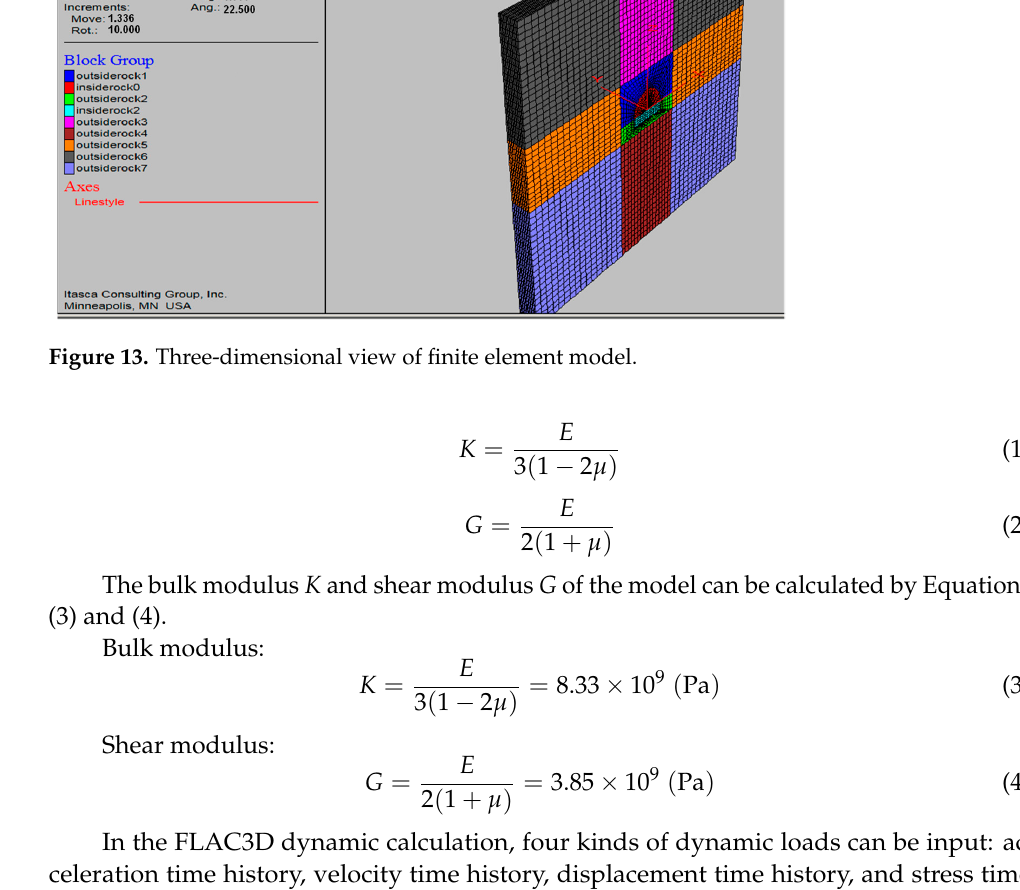
Figure 15. Data after electronic detonator vibration test and transition. The loose circles of the tunnel blasted by nonelectric detonators and electronic deto- nators were obtained by numerical calculation, as shown in Figures 16 and 17. The blue elements in the figures represent the undamaged surrounding rock. The green, brown and